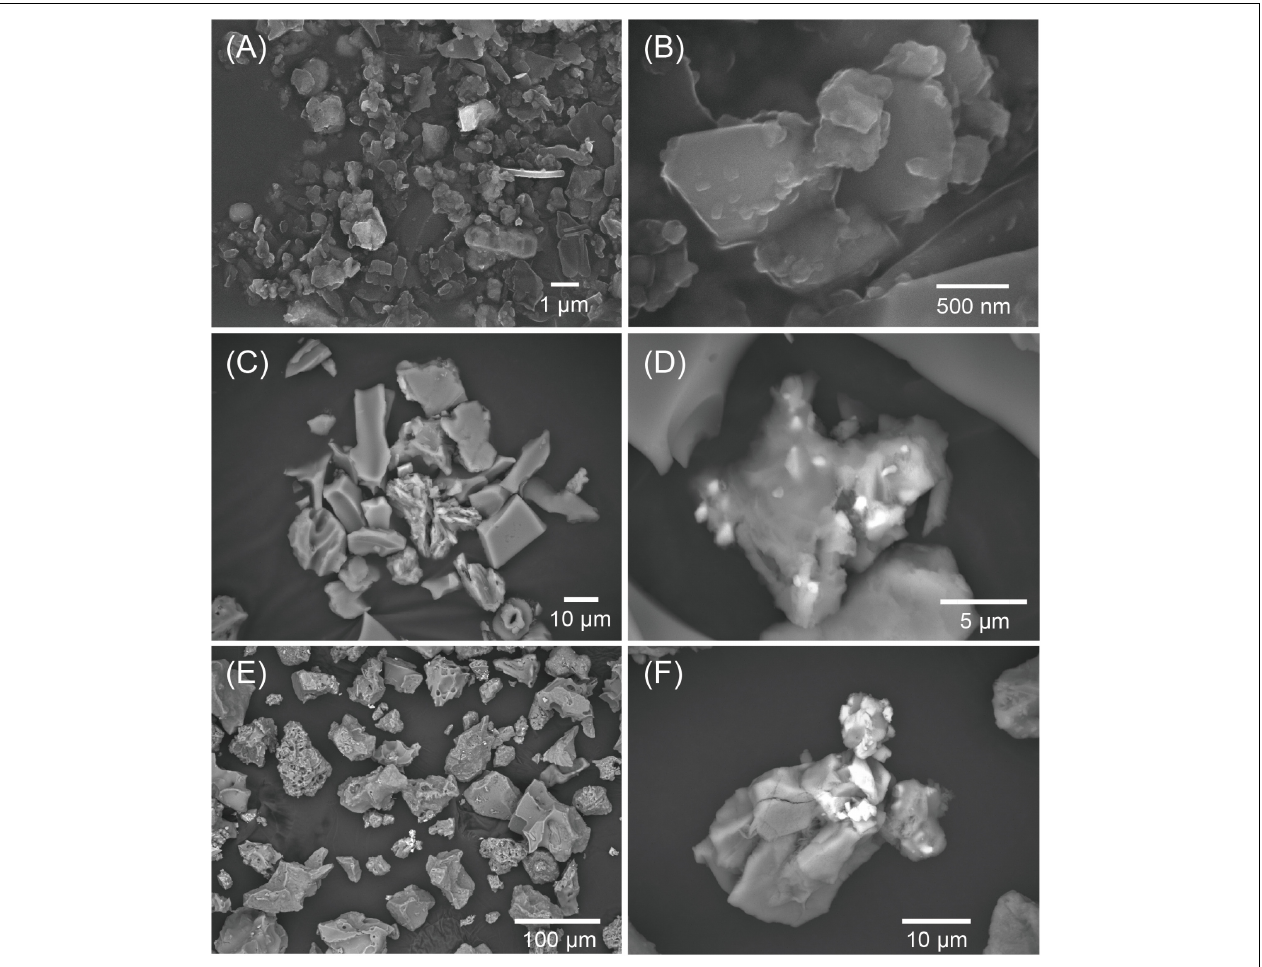
FIGURE 5 | Scanning electron microscopy (SEM) photos of magnetic extracts for (A,B) the < 2 µ m and (C,D) the 8–31 µ m fractions of the 231 ka (361 cm depth) sample. (E,F) SEM photos for volcanic ash layer (275 ka, 470 cm depth) are presented for comparison. Representative chemical compositions are shown in Supplementary Figures S2–S4